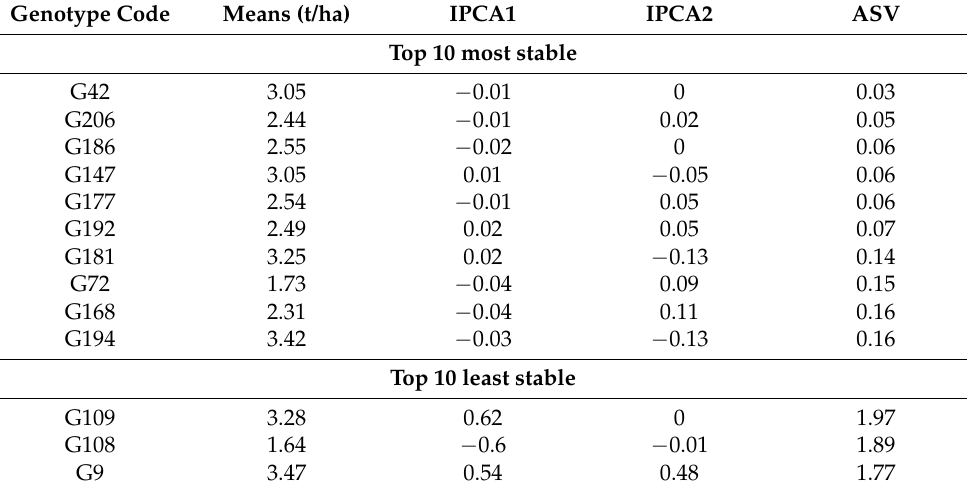
Table 8. Mean grain yield value, IPCA-1 and IPCA-2 scores, and AMMI stability values (ASV) of 225 sorghum genotypes for grain